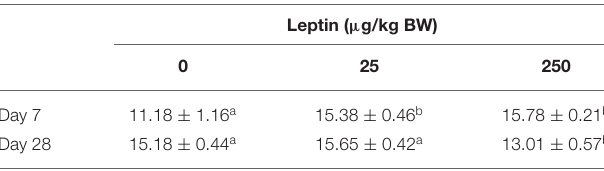
BW, body weight. Different superscripts in same row are significantly different. Data represent the mean ± SEM (n =